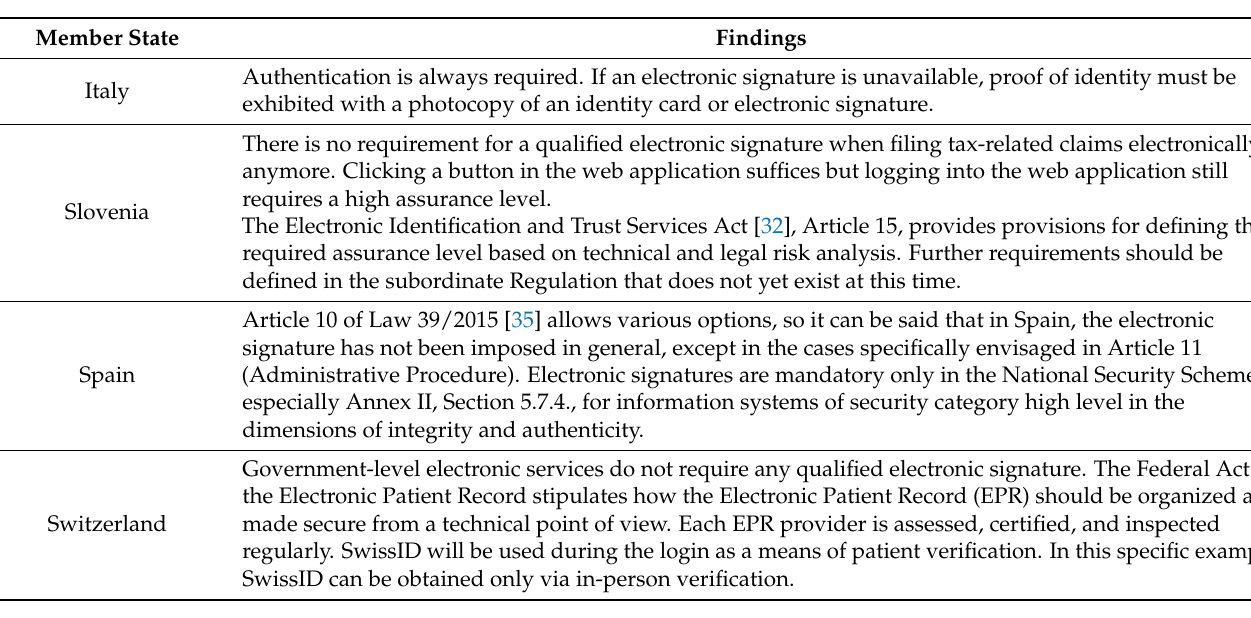
Table 4. The use of electronic signatures in public administration for the sampled